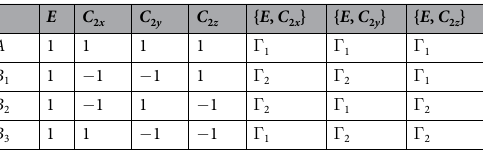
Table 2. Character table and compatibility relations of the point group 222 ( D 2